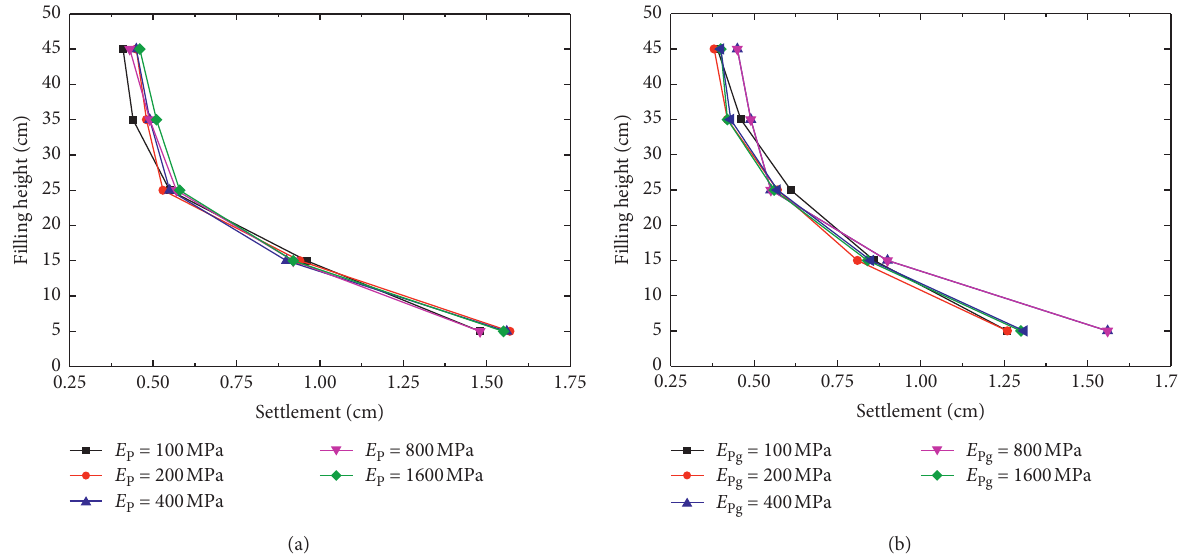
Figure 14: Variation of the settlement with filling height under different pile modulus conditions. (a) Unreinforced condition. (b) One-layer geogrid-reinforced condition.